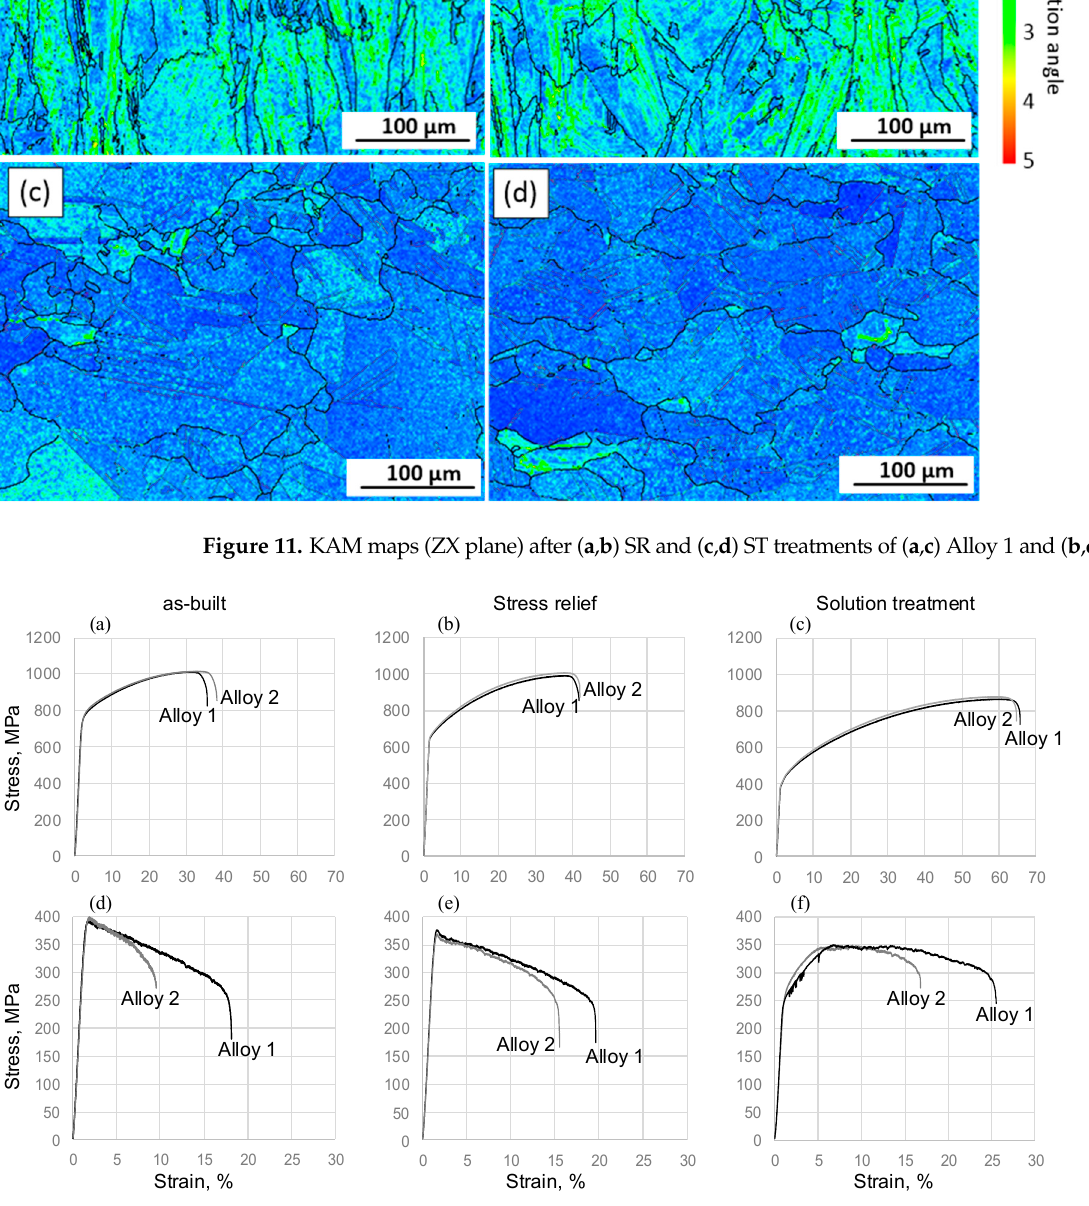
Figure 12. Tensile behavior of Alloys 1 and 2 at ( a – c ) room temperature and ( d – f ) 760 °C; ( a , d ) the as-built state, ( b , e ) after the SR and ( c , f ) after the ST treatments. Table 2. Mechanical properties of the LPBF IN625 alloys.